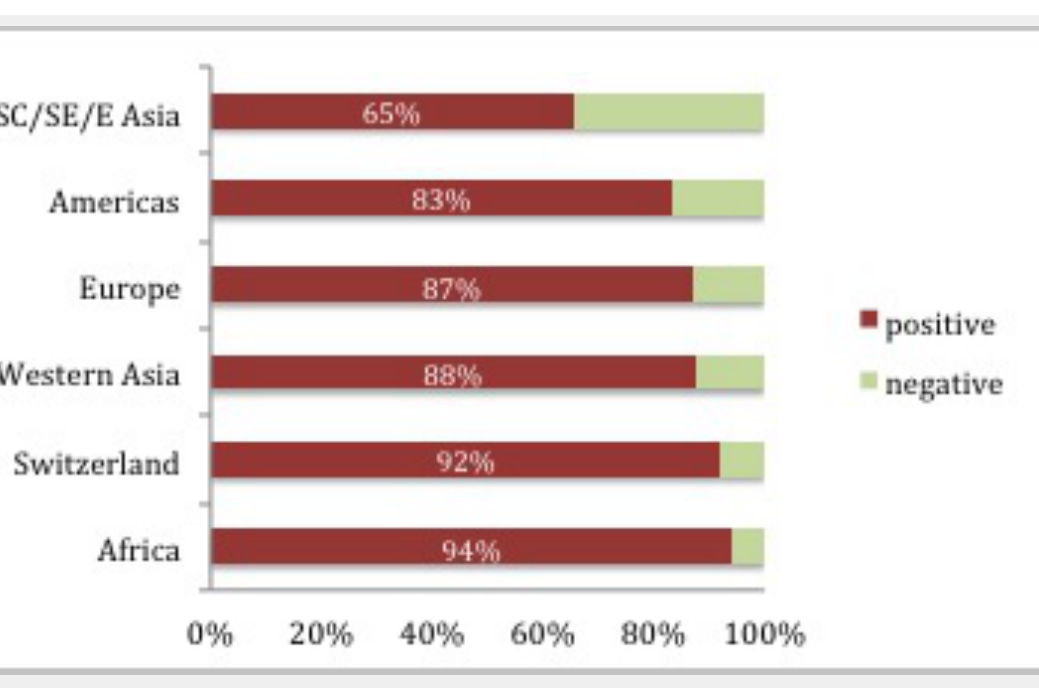
Figure 2 Varicella seropositivity according to nationality in travellers seeking pre-travel advice at the Travel Clinic of the University of Zurich between December 2008 and August 2015 who had an uncertain or negative varicella history (n = 1749). SC = South Central; SE = South-East; E = East; Europe = European countries except Switzerland; χ 2 test p